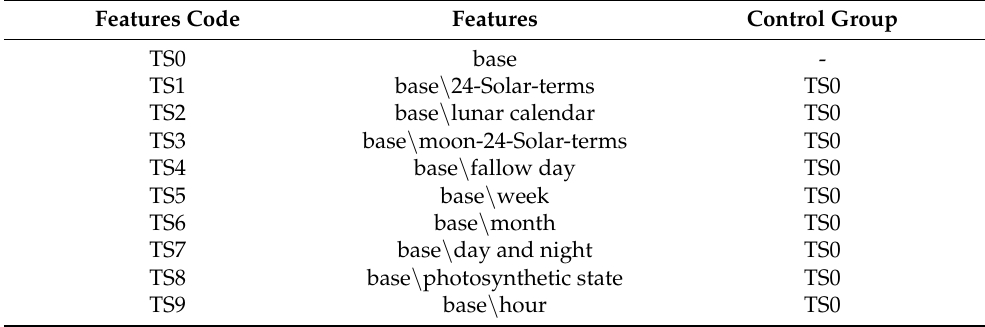
Table 4. Time series feature treatments.